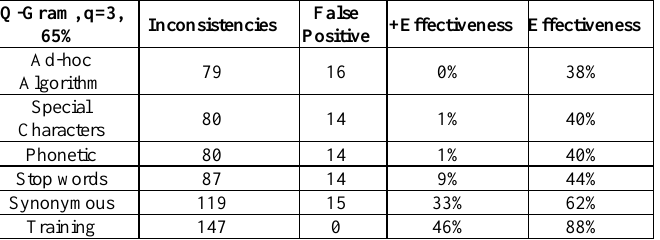
Table 12: Results obtained with data cleaning process using the algorithm Q-Grams, with q=3 and 65% similarity.